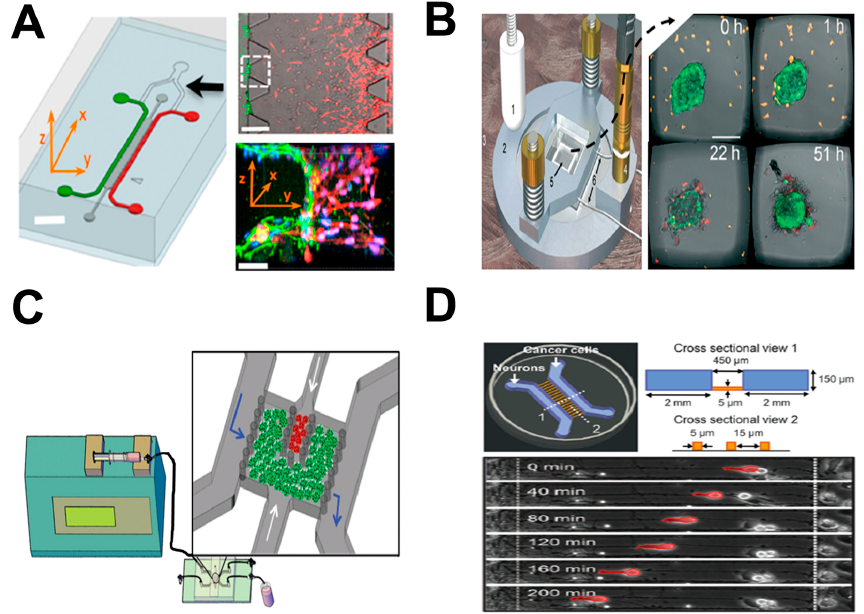
Figure 2. Examples of tumor-on-chip cell migration study. ( A ) The 3D microfluidic model for investigating endothelial barrier function during tumor cell intravasation. The left panel shows the microfluidic device (green: endothelial cell channel; red: tumor channel; dark gray: 3D ECM channel; black arrow: Y junction); the upper-right panel shows a representative phase-contrast image of tumor cell (red) invasion through 3D ECM region (dark gray) to the endothelium (green); the bottom-right panel shows a 3D confocal image of the selective area in the white-dashed square (red: tumor cells; green: endothelium). ( B ) The ultrasonics-based 3D microdevice for studying immune surveillance of NK cells for specific tumors. The left panel illustrates the main components of the microfluidic system; the right panel shows some representative experimental images of NK–tumor interaction at different time points (orange: NK cells; green: solid tumors). ( C ) The breast-cancer-on-chip model to investigate ECM activation during tumor progression. The figure shows the microfluidic system and magnified view of the chip (green: stromal microtissues; red: tumor microtissues; blue arrow: fluid flow direction; white arrow: 3D microtissue injection direction). ( D ) The tumor-on-chip model to investigate the interactions between neurons and cancer cells during tumor PNI. The upper panel illustrates the microfluidic device; the bottom panel shows a representative image of tumor cell (red) migration behavior along the contacted neurites at different time points. Figure 2A was adapted from reference [36] with permission from the National Academy of Sciences; Figure 2B was adapted from reference [37] with permission from the Royal Society of Chemistry; Figure 2C was adapted from reference [38] with permission from John Wiley and Sons; Figure 2D was adapted from reference [39] with permission from the Royal Society of Chemistry.